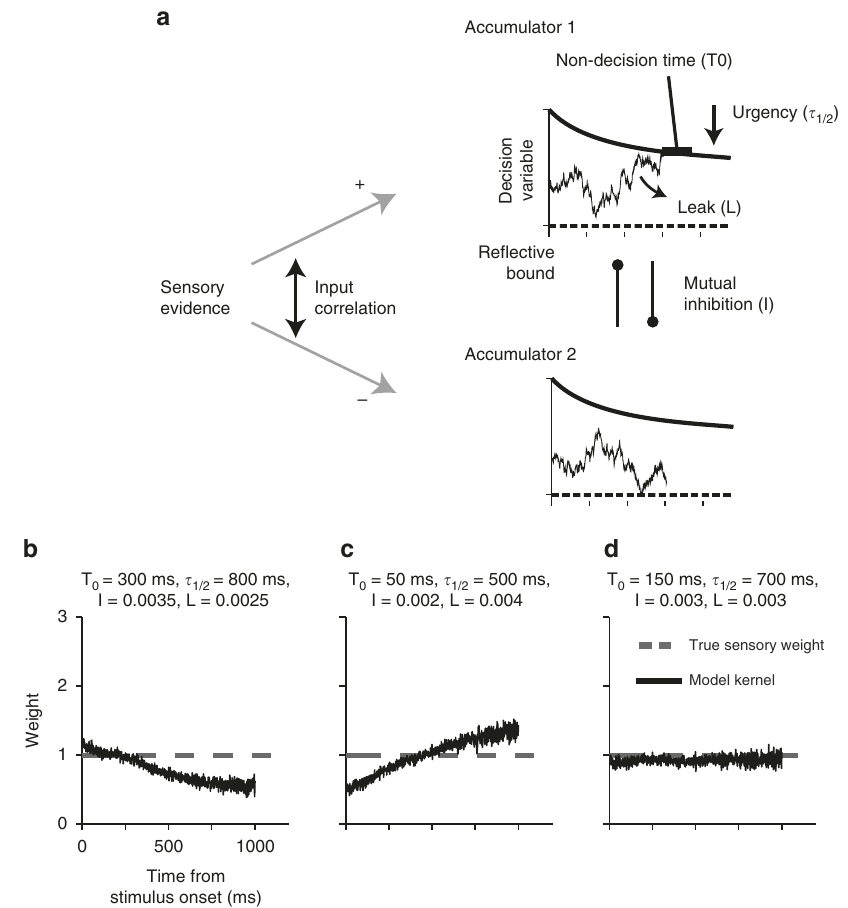
Fig. 7 A decision-making model that has a mixture of parameters with opposing effects on psychophysical kernels can create a diversity of kernel dynamics for static sensory weights. a A model composed of two competing integrators that allows different ratios of leak and inhibition, collapsing decision bounds, and non-decision times. The model also has input correlation > − 1 and re fl ective lower bounds, but they are fi xed for simplicity. b When bound collapse is small and non-decision times are long, the kernel drops monotonically over time. c When bound collapse is large and non-decision times are short, the kernel rises monotonically. d When these opposing factors balance each other, the kernel becomes fl